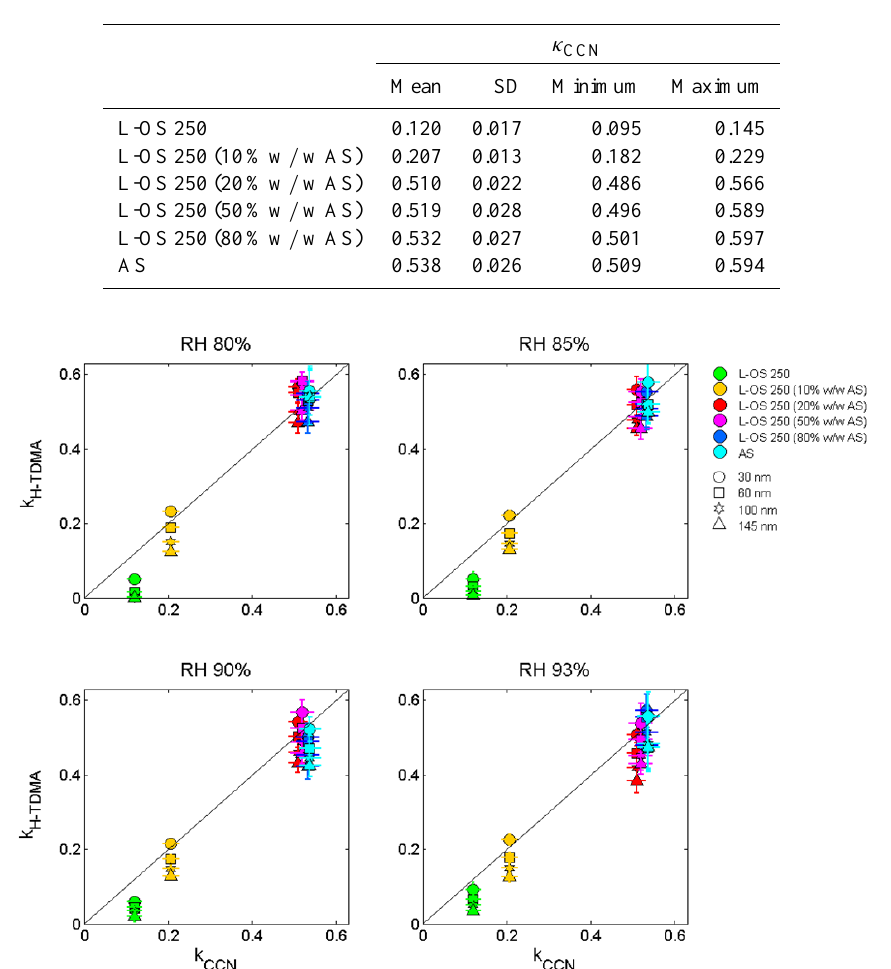
Table 3. Mean, minimum and maximum values of the hygroscopicity parameter, κ , obtained from the CCN measurements, as well as standard deviations (SD).